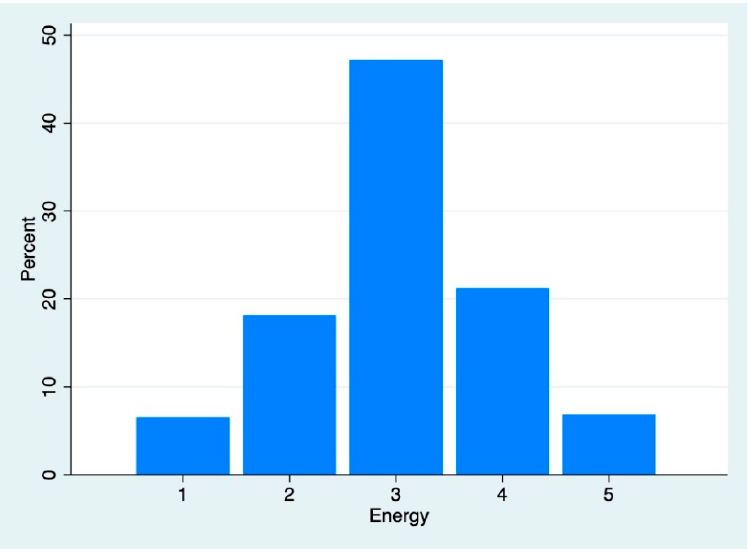
Figure 2. Distribution of participants’ energy.